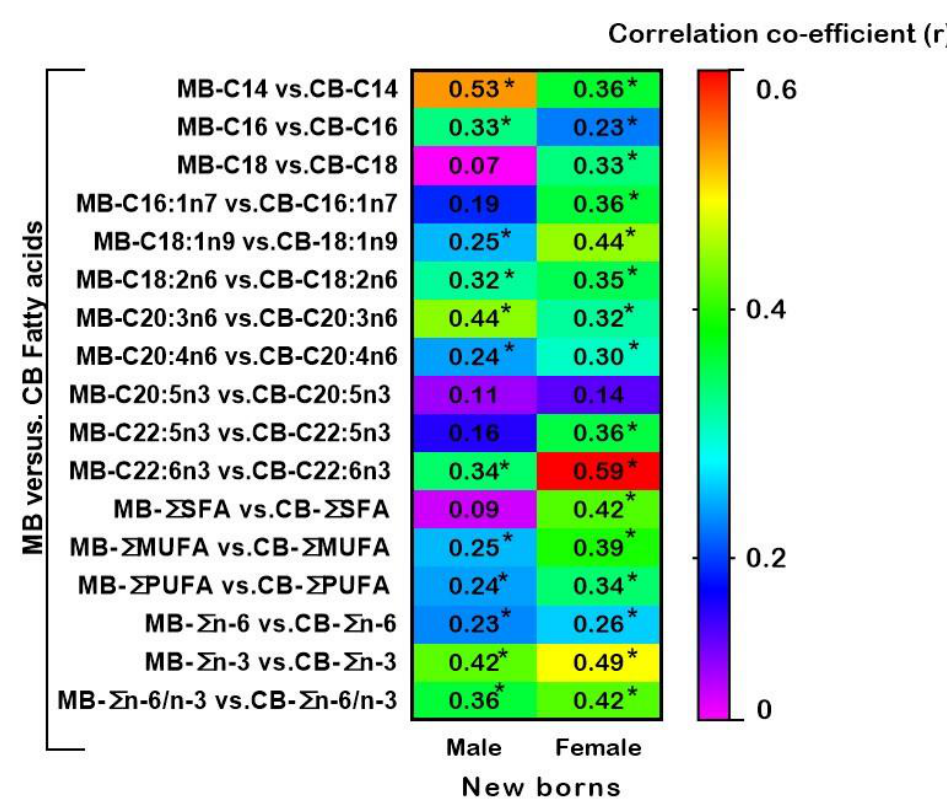
Figure 3. Heatmap of correlation co-efficients between individual fatty acids (%) of MB and CB at birth. A strong relationship exists between MB versus CB C22:6n3 (DHA) of female newborns. * p < 0.05 between compared MB and CB fatty acids. See also Supplementary Tables S2 and S3 for details.